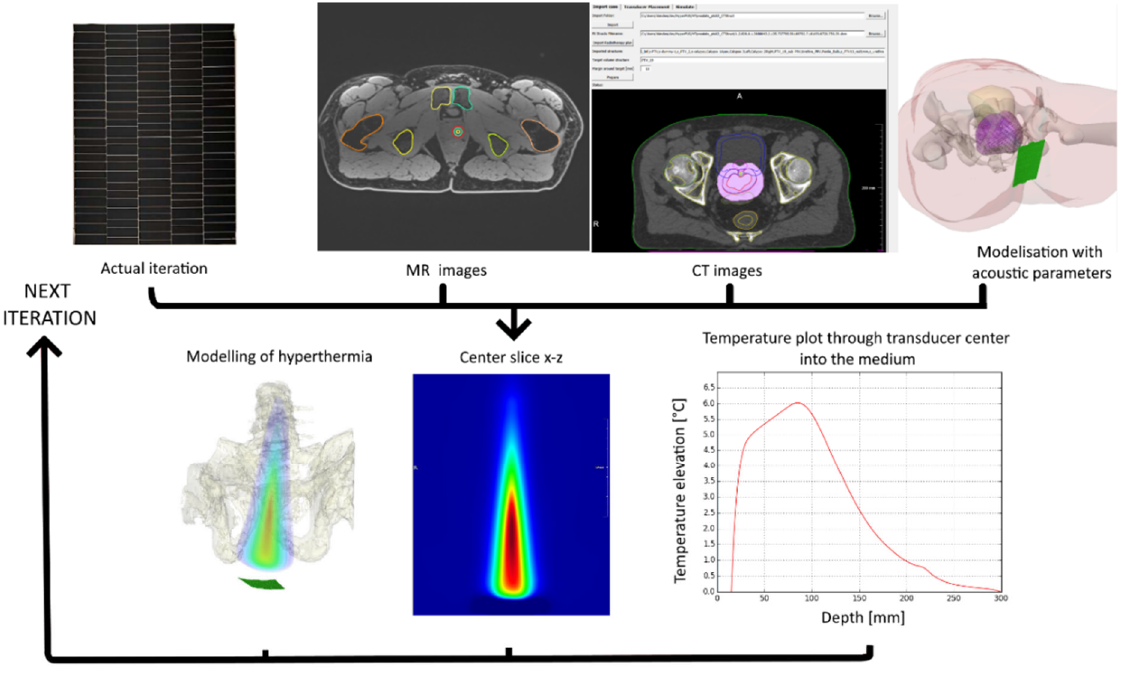
Figure 1. Iterative process of transducer design. A first design was tested with images from a CT scan of a patient and a modelisation software. The obtained results permitted to adjust individual elements’ position on the transducer.